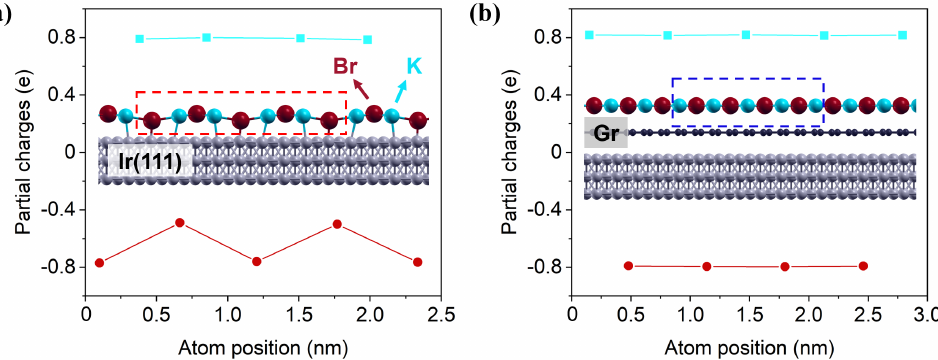
Figure 2. Simulated model (lateral view) of both KBr structures with the partial charges in the dotted box of the model calculated by the Bader method (K in blue, Br in red, C in black and Ir in gray): ( a ) KBr/Ir(111), ( b )